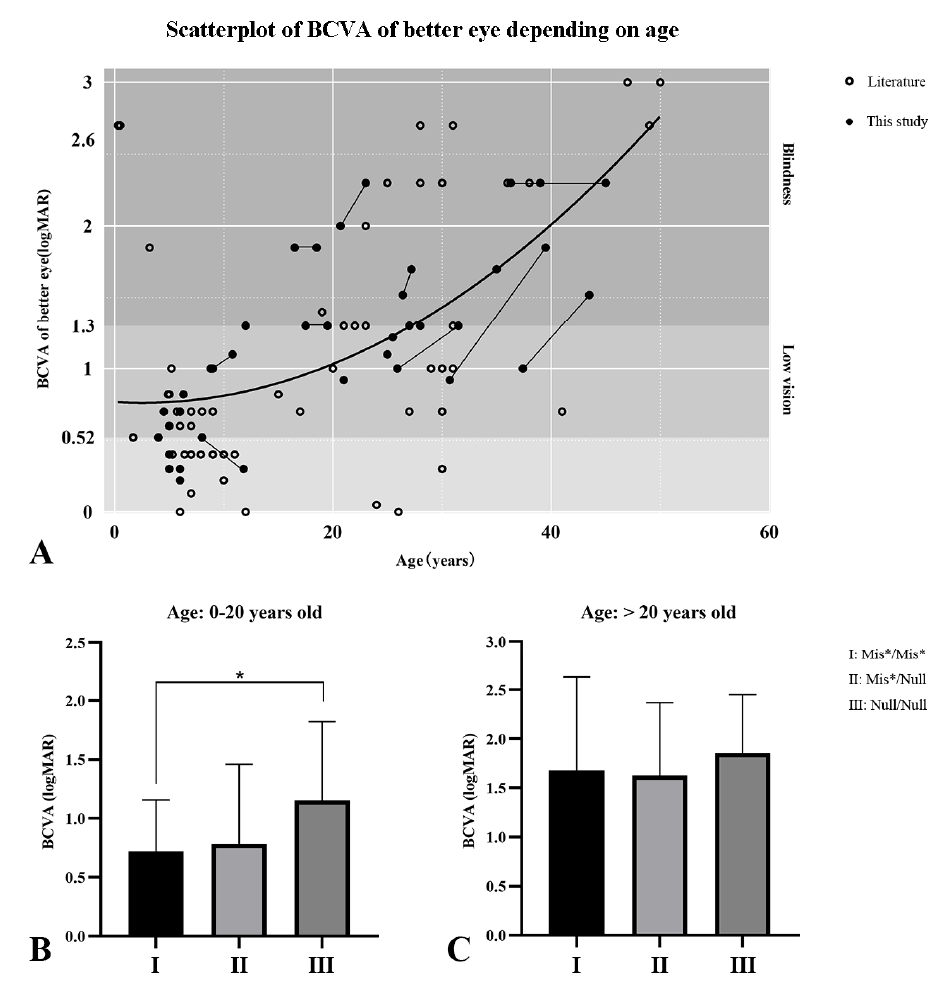
Figure 2. The best-corrected visual acuity (BCVA) for the better-seeing eye as a function of age, and the relationship between BCVA and genotype. ( A ) The BCVA as a function of age in the 84 better- seeing eyes of 84 patients with RPE65-IRD, including the 27 patients in our cohort (black dots) and 57 patients from eight previously published Chinese studies (black circles). When serial data were available ( n = 10), visual acuities from the same eye at the first and the latest evaluation were plotted and connected by lines. The thicker line is the quadratic function of the best fit. ( B , C ) Comparison of the BCVA of patients with different genotypes in two age groups. For patients under 20 years of age ( B ), the numbers of patients with I, II and III genotypes were 26, 12, and 9, respectively; for patients older than 20 years ( C ), these numbers were 16, 16, and 5, respectively. A significant difference was found between I and III genotypes in the patients under 20 years of age (* p < 0.05). No difference was found among other subgroups. Mis*: missense or in-frame deletion variant. Null: null variant.